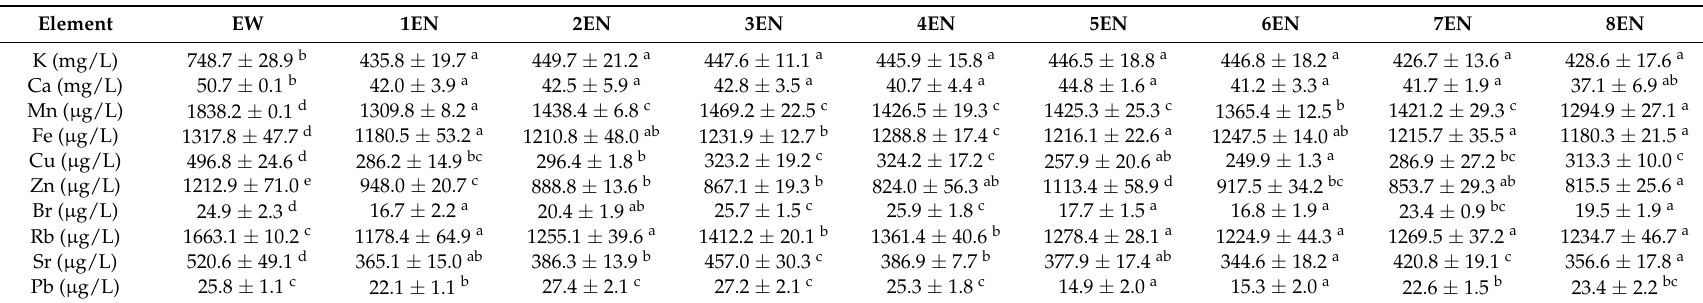
Table 10. Content of elements in the initial ecological Cabernet Sauvignon wine and NF retentates obtained at 2.5, 3.5, 4.5 and 5.5 MPa with cooling and without cooling. Significant differences ( p < 0.05) between samples are indicated by different superscript letters (a, b, c, d, e) within the row (ANOVA, Fisher’s LSD test).